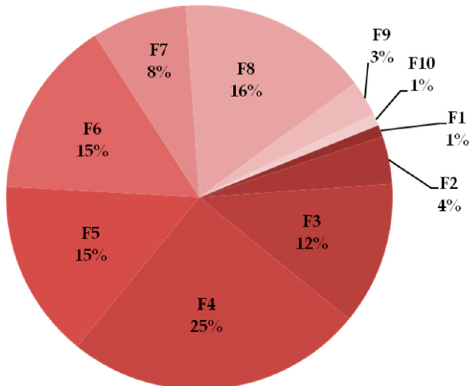
Figure 2. Percentage share of collected proteins in particular fractions from AUC analysis in ChromeLab.